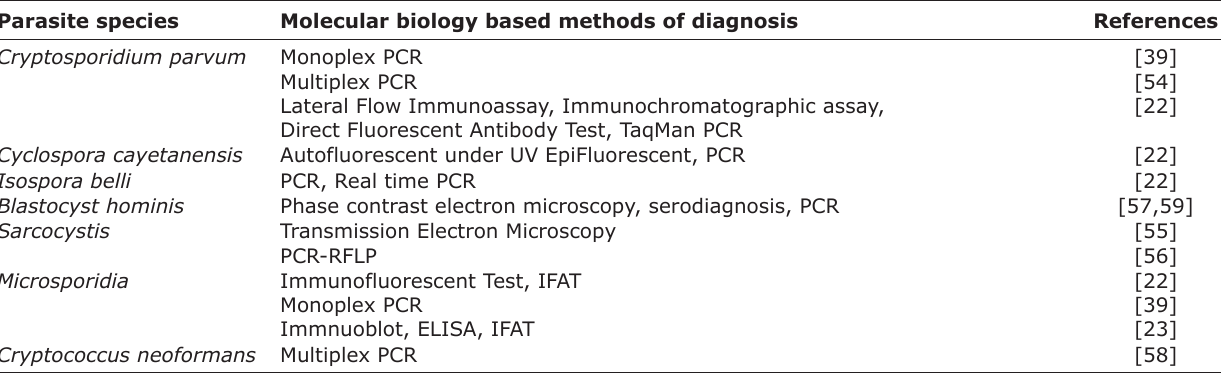
Table-3: Diagnosis methods based on modern molecular biology of opportunistic parasitic infection. Parasite species Molecular biology based methods of